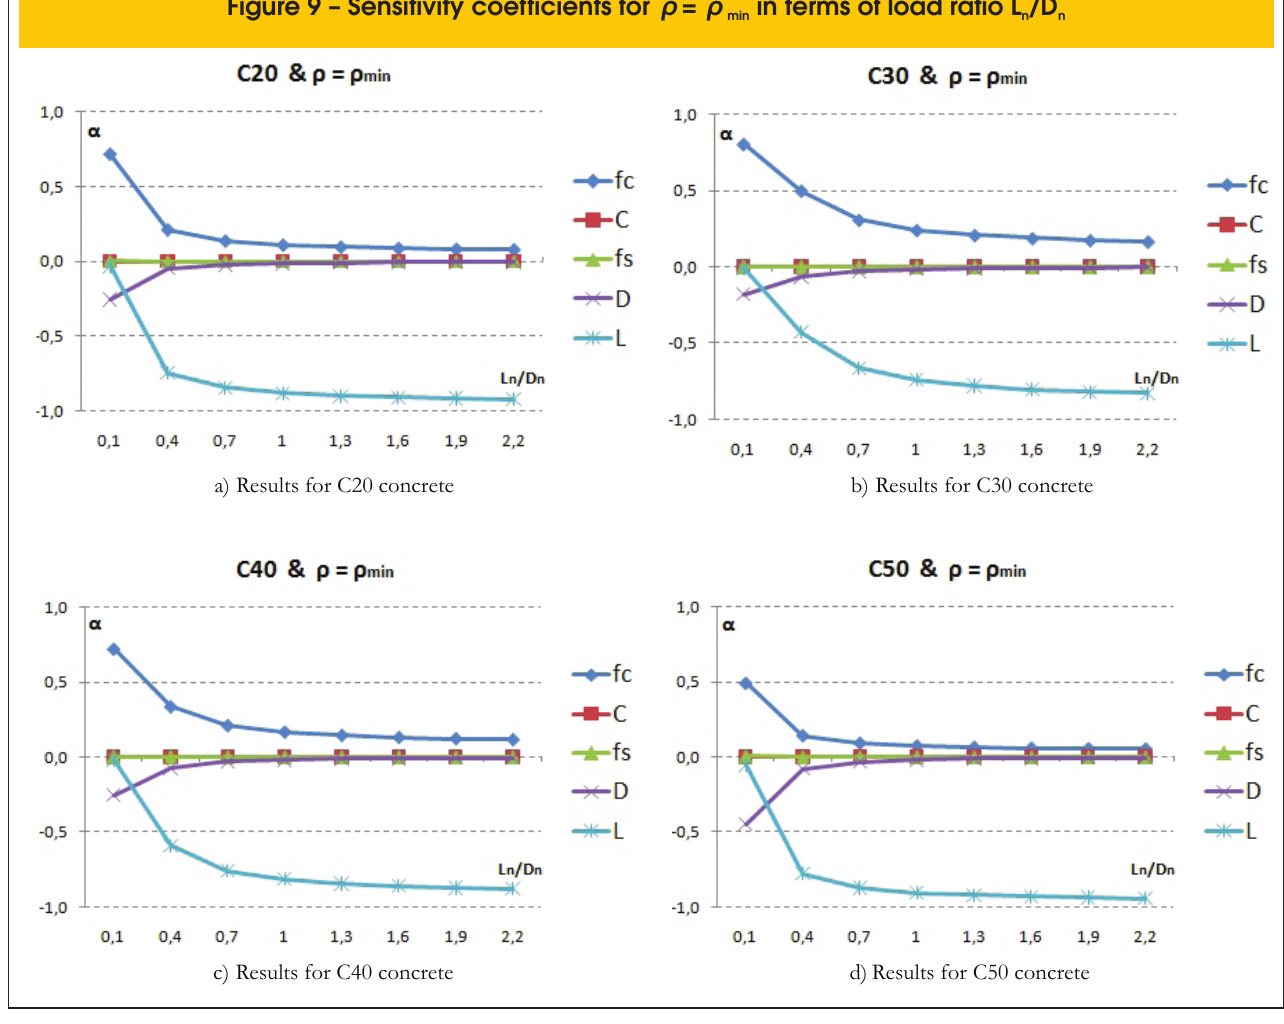
Figure 9 – Sensitivity coefficients for ρ = ρ in terms of load ratio L /D